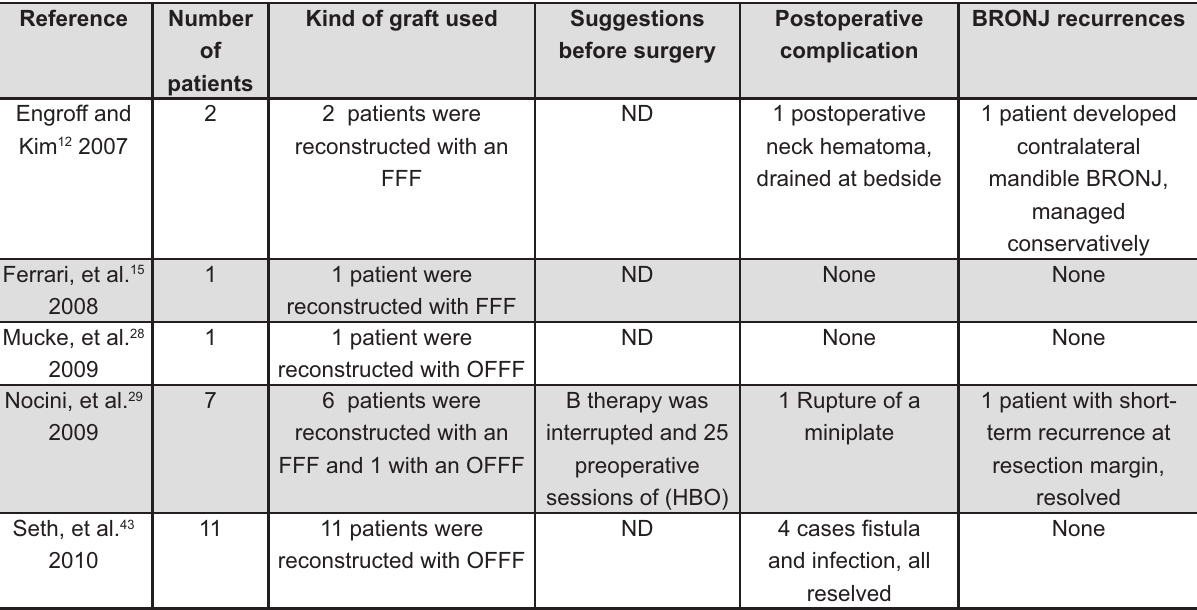
Figure 7- (cid:12)>(cid:9)(cid:10)(cid:30)(cid:4)(cid:19)(cid:5)(cid:12)(cid:21)(cid:19)(cid:9)(cid:21)(cid:4)(cid:19)(cid:27)(cid:19)(cid:30)(cid:12)(cid:13)(cid:21)(cid:7)(cid:23)(cid:12)(cid:9)(cid:18)(cid:19)(cid:12)(cid:21)(cid:19)(cid:27)(cid:4)(cid:19)(cid:20)(cid:12)(cid:7)(cid:13)(cid:12)(cid:9)(cid:18)(cid:19)(cid:12)(cid:31)(cid:4)(cid:9)(cid:19)(cid:21)(cid:11)(cid:9)(cid:10)(cid:21)(cid:19)^(cid:12)(cid:11)(cid:8)(cid:11)(cid:31)(cid:29)(cid:5)(cid:4)(cid:5)(cid:12)(cid:7)(cid:13)(cid:12)(cid:9)(cid:29)(cid:17)(cid:19)(cid:12)(cid:7)(cid:13)(cid:12)(cid:21)(cid:19)(cid:6)(cid:7)(cid:8)(cid:5)(cid:9)(cid:21)(cid:10)(cid:6)(cid:9)(cid:4)(cid:7)(cid:8)(cid:12)_(cid:24)(cid:16)(cid:10)(cid:31)(cid:11)(cid:12)(cid:13)(cid:21)(cid:19)(cid:19)(cid:12)H(cid:11)(cid:17)(cid:12)(cid:22)(cid:12)‘‘‘(cid:12) (cid:11)(cid:8)(cid:30)(cid:12)(cid:7)(cid:5)(cid:9)(cid:19)(cid:7)(cid:6)(cid:10)(cid:9)(cid:11)(cid:8)(cid:19)(cid:7)(cid:10)(cid:5)(cid:12)(cid:24)(cid:16)(cid:10)(cid:31)(cid:11)(cid:12)(cid:13)(cid:21)(cid:19)(cid:19)(cid:12)H(cid:11)(cid:17)(cid:12)(cid:22)(cid:12)%‘‘‘{(cid:28)(cid:12)(cid:17)(cid:11)(cid:21)(cid:9)(cid:4)(cid:6)(cid:10)(cid:31)(cid:11)(cid:21)(cid:12)(cid:17)(cid:21)(cid:7)(cid:6)(cid:19)(cid:30)(cid:10)(cid:21)(cid:19)(cid:5)(cid:12)(cid:16)(cid:19)(cid:13)(cid:7)(cid:21)(cid:19)(cid:12)(cid:5)(cid:10)(cid:21)!(cid:19)(cid:21)(cid:29)(cid:12)_(cid:18)(cid:29)(cid:17)(cid:19)(cid:21)(cid:16)(cid:11)(cid:21)(cid:4)(cid:6)(cid:12)(cid:7)?(cid:29)!(cid:19)(cid:8)(cid:12)(cid:9)(cid:18)(cid:19)(cid:21)(cid:11)(cid:17)(cid:29)(cid:12)(cid:22)(cid:12)(cid:26)#%{(cid:28)(cid:12) postoperative wound complications and bisphosphonate-related osteonecrosis of jaws (BRONJ) recurrences